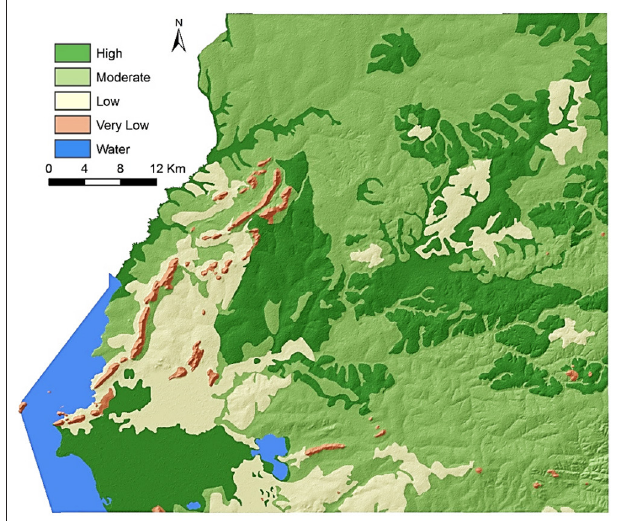
FIGURE 8 | Availability of moisture for plant growth for the Busia